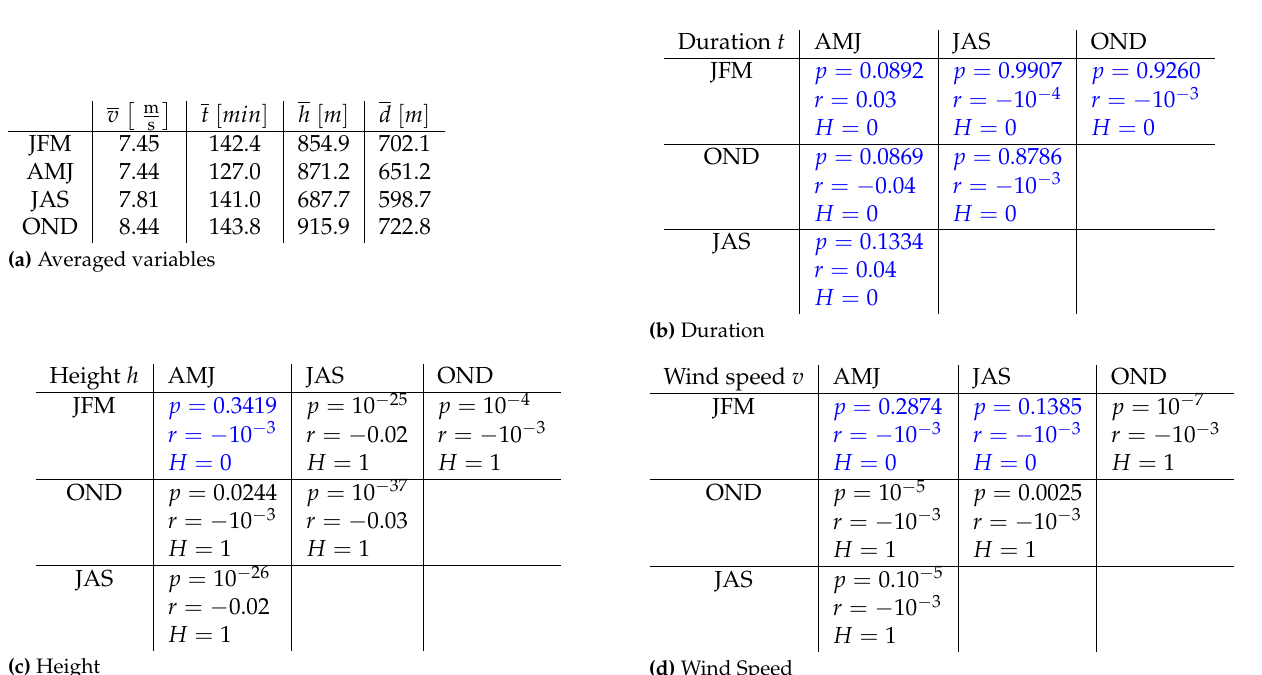
Figure 12. Seasonal averages of the variables ( a ) as well as seasonal correlation of duration ( b ), height ( c ) and wind speed ( d ). p is the significance level of the Mann–Whitney U test, with H = 0 the null hypothesis cannot be rejected (values are marked in blue), and H = 1 the null hypothesis can be rejected. The Pearson correlation coefficient, r , is also given for all of the